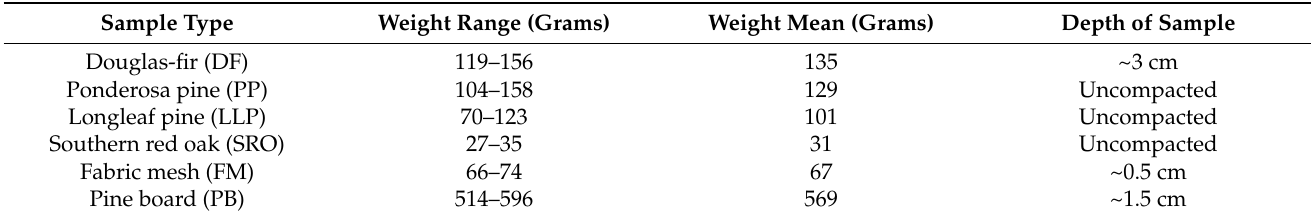
Table 1. Sample types and weights used in this study. “Uncompacted” indicates the samples that naturally had a lot of open area with no readily defined depth. Litter fuels were allowed to extend upwards out of the sample trays to mimic natural conditions.